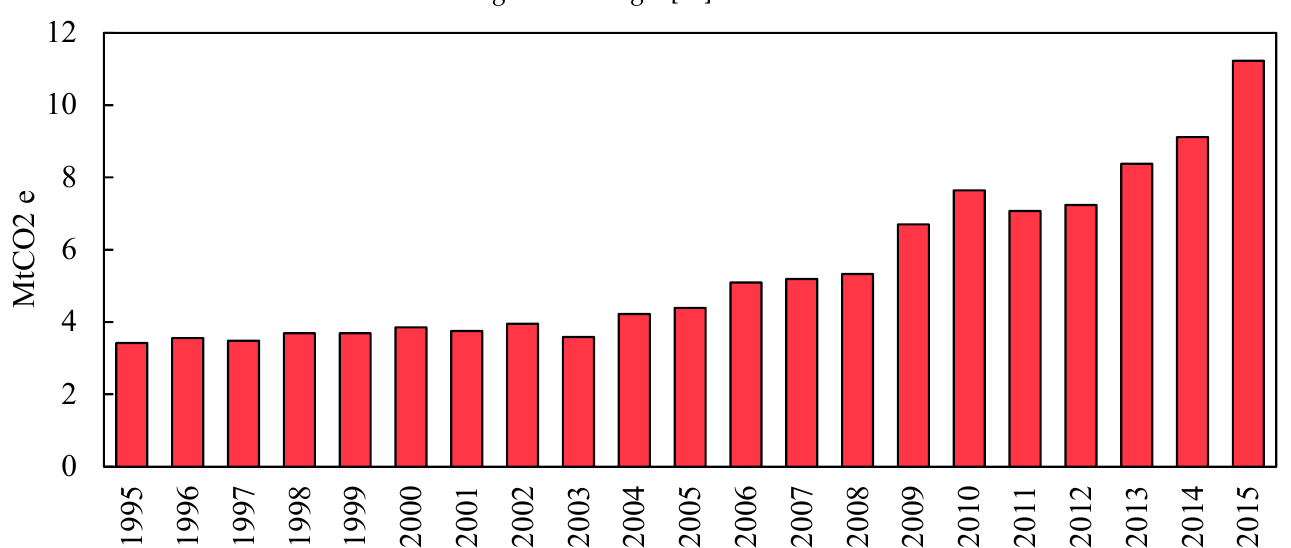
Figure 2. Trend of transport sector emissions (MtCO 2 e), excluding waterborne navigation (data according to [14]).